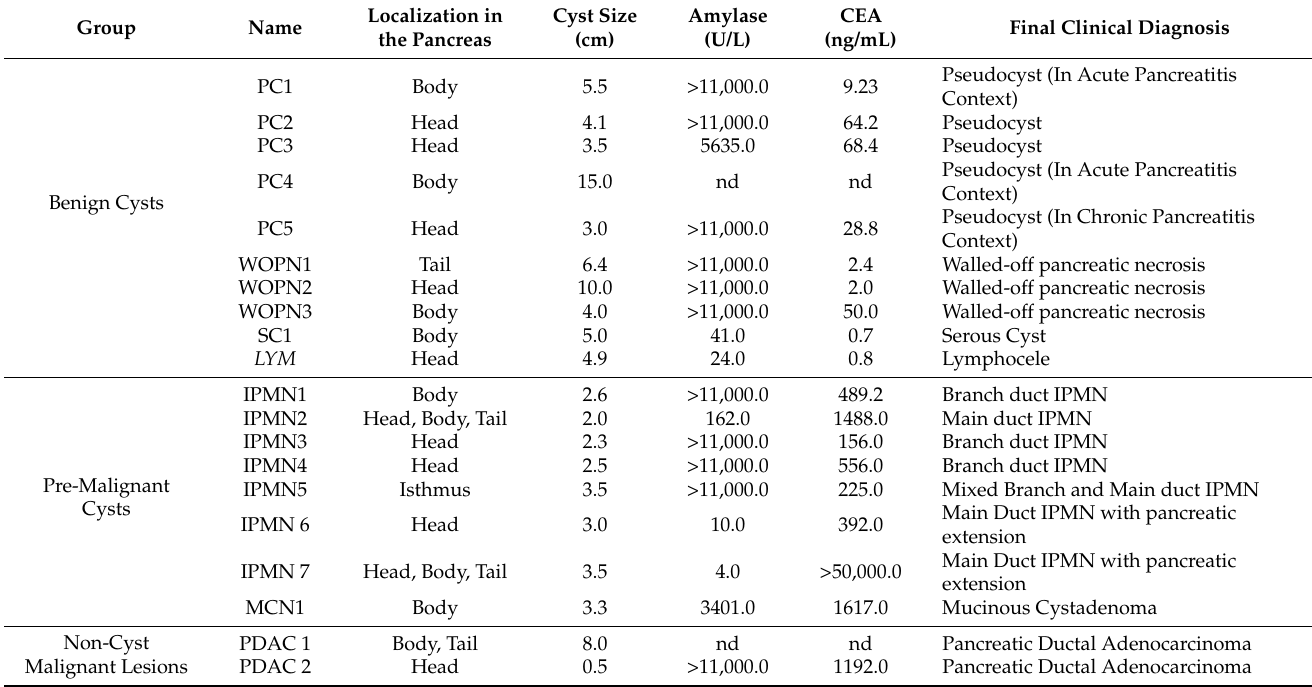
Table 2. Clinical Cyst Sample